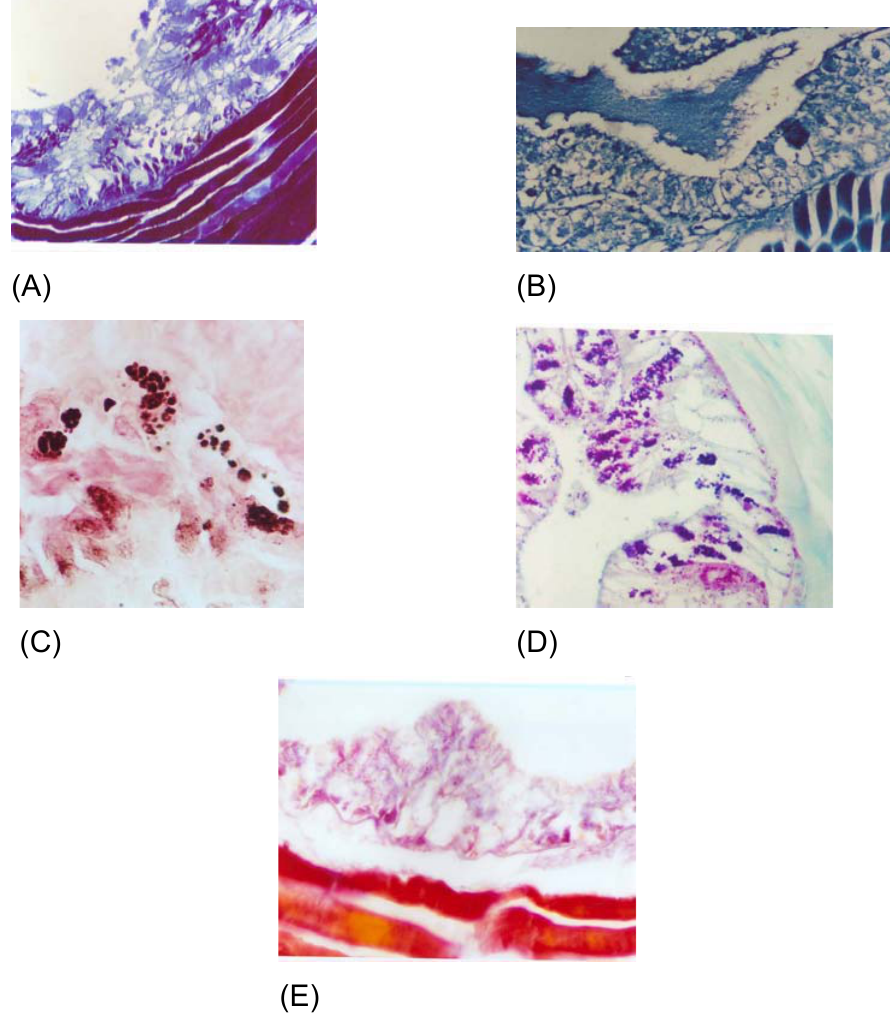
Figure 2. Cross-section of A. crassicauda venom glands showing: ( A ) proteins; ( B ) cysteine; ( C ) tyrosine; ( D ) tryptophan; ( E )